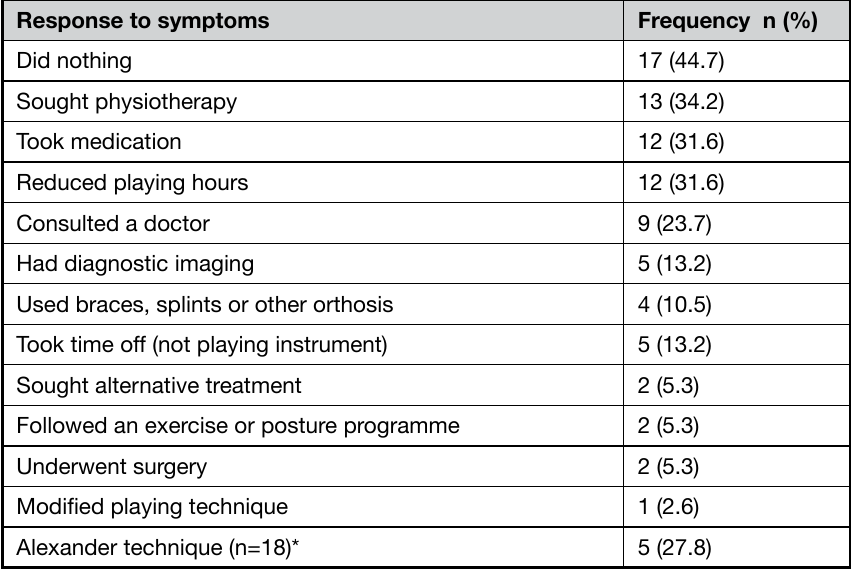
Table 2. Action taken by participants (n=38) in response to symptoms experienced while playing their